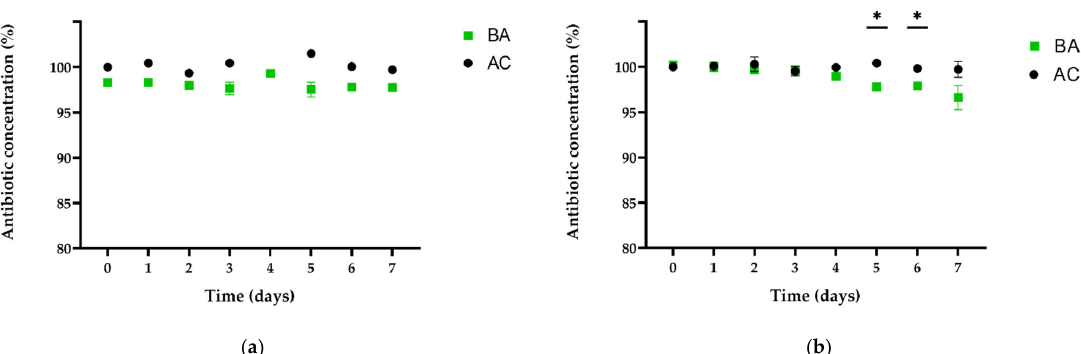
Figure 3. Antibiotic concentration (%) for TYL A in supernatants of pipes without biofilm (AC) or with 7-day-old biofilms (BA). Results are shown for daily samplings starting 1 h after application (0) over 7 days. ( a ) Data for biofilms with P. aeruginosa; ( b ) Data for biofilms with P. fluorescens. * Concentrations significantly different between antibiotics confronted to biofilms and control pipes ( t -test; p < 0.05). T4 of the left figure ( a ) shows only data for BA.